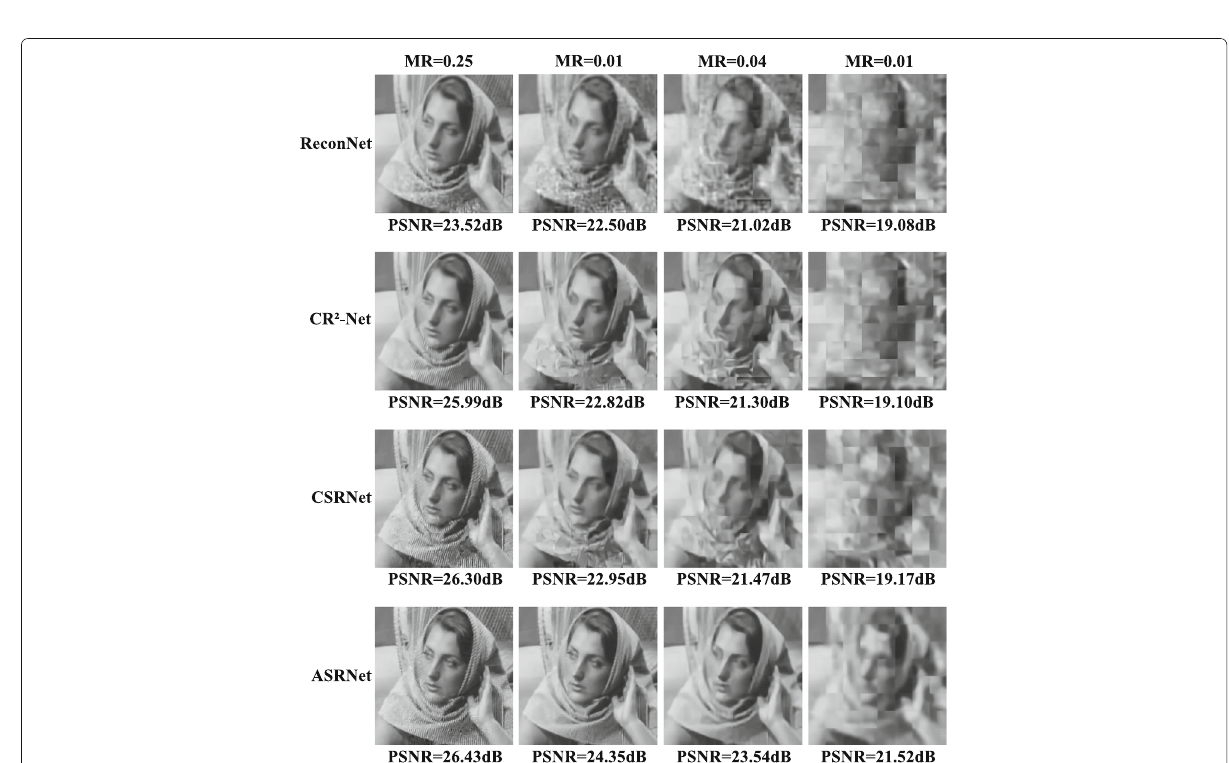
Fig. 14 The reconstruction results of Barbara at the measurement rate of 0.25, 0.1, 0.04, and 0.01 with